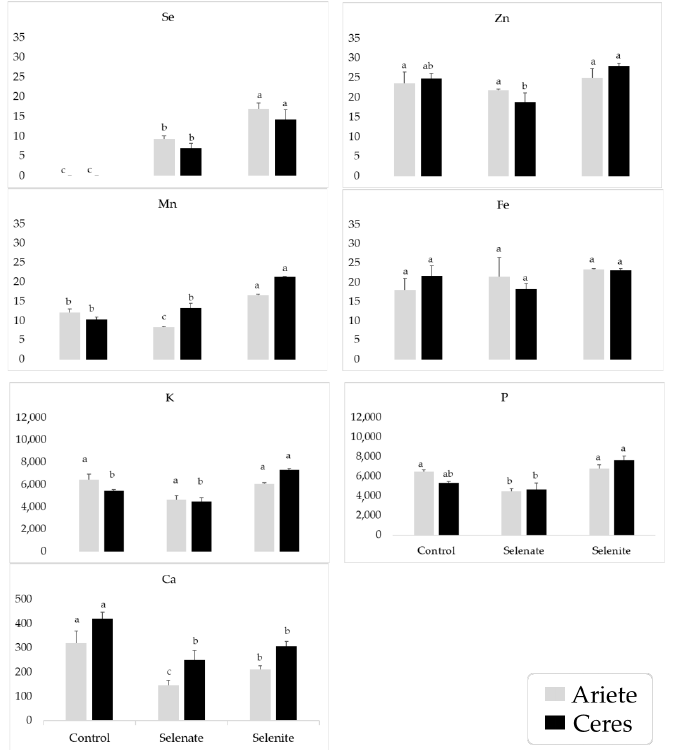
Figure 2. Average (µg g −1 ) ± standard error ( n = 3) of Selenium, Zinc, Manganese, Iron, Potassium, Phosphorus, and Calcium concentrations in the brown rice grains. Letters a, b, and c indicate significant differences between treatments, for each variety ( p ≤ 0.05).